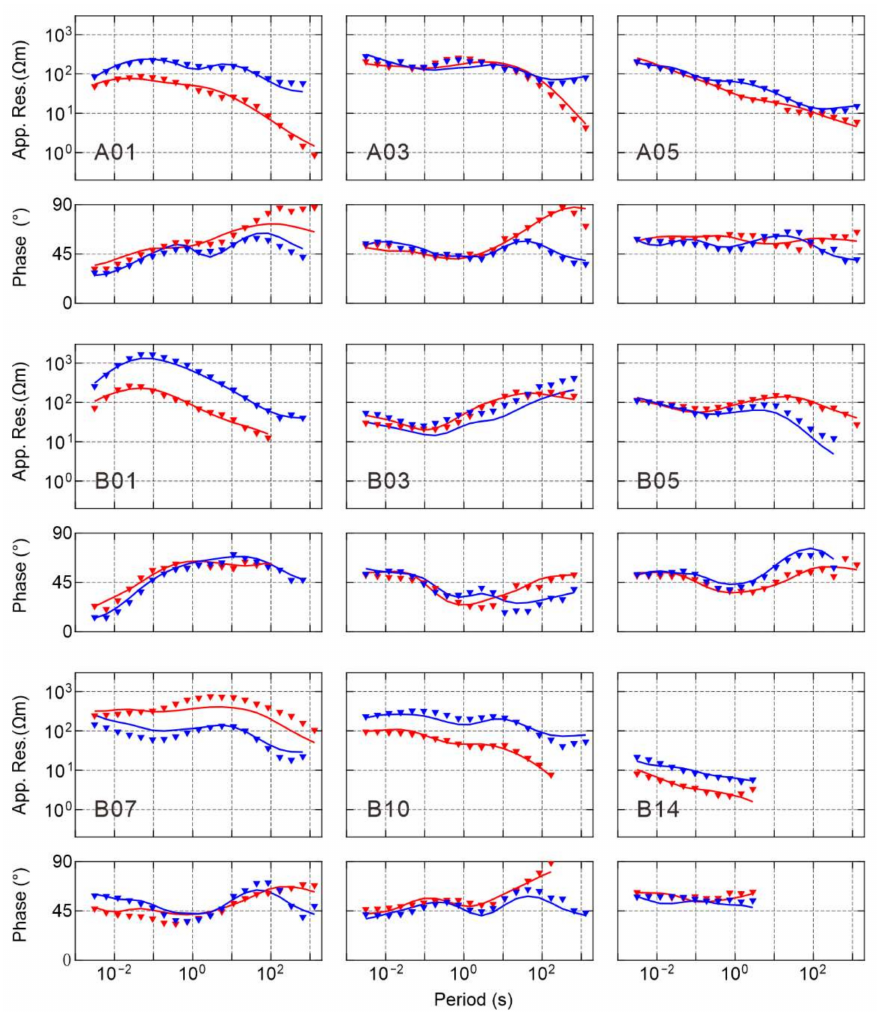
Figure 4. Observed (triangles) and calculated (solid lines) apparent resistivities and phase curves at nine typical MT sites. The red triangles and solid lines represent the XY-mode, and the blue triangles and solid lines represent YX-mode data in the observation coordinate system. The X-axis is aligned with the geomagnetic